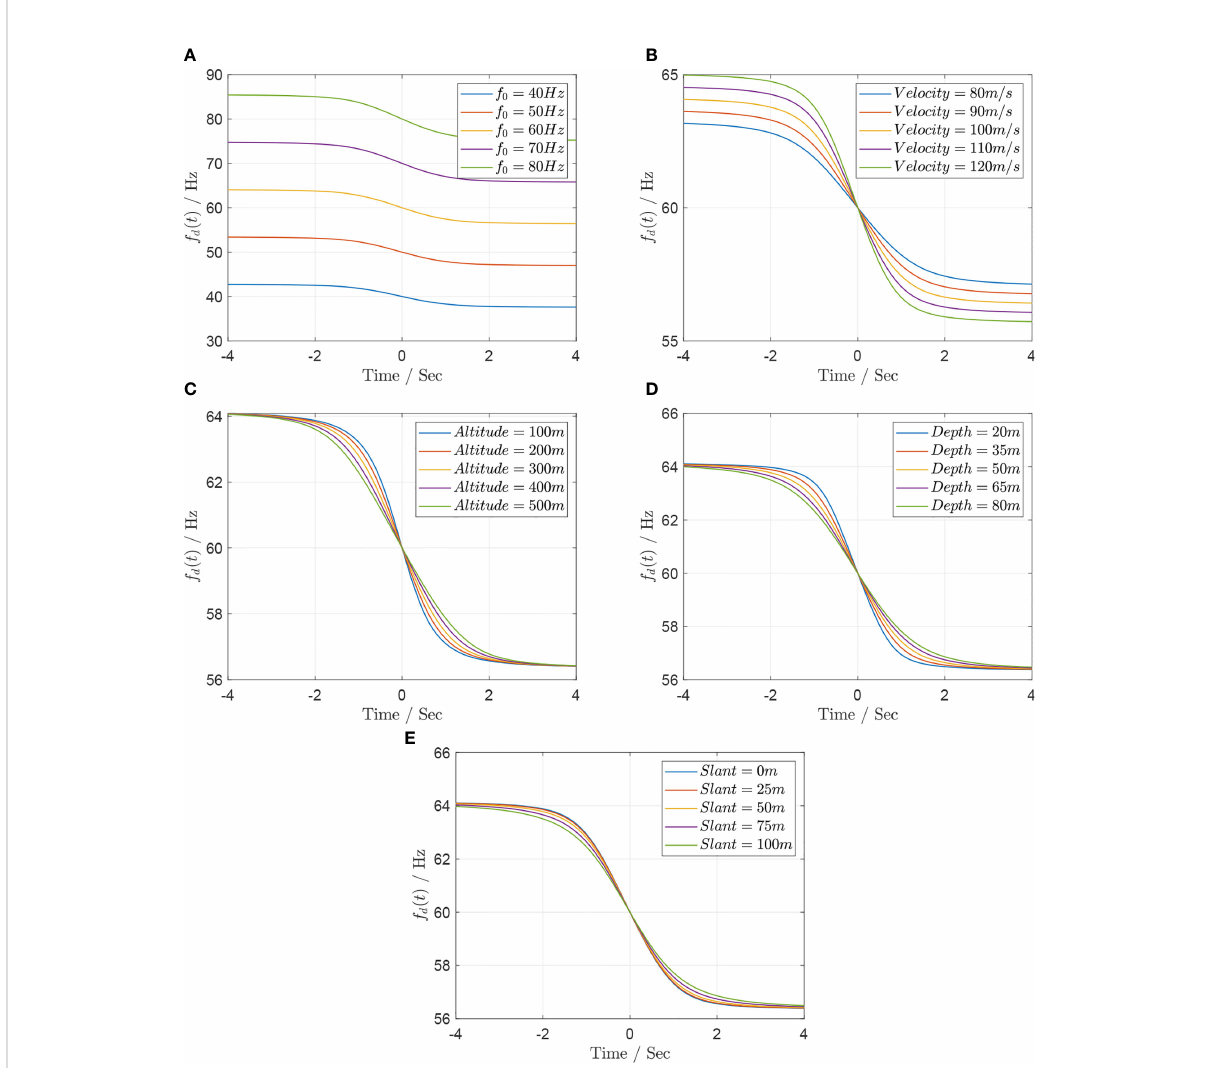
FIGURE 4 (A) Doppler shift curve f d ( t ) versus frequency f ∈ [30, 70] Hz every 10 Hz, assuming v = 100 m/s, h = 300 m, d = 50 m, and wmin = 50 m. (B) Doppler 0 shift curve f d ( t ) versus frequency v ∈ [80, 120] m/s every 10 m/s, assuming f 0 = 60 m/s, h = 300 m, d = 50 m, and wmin = 50 m. (C) Doppler shift curve f d ( t ) versus frequency h ∈ [100, 500] m every 100 m, assuming f 0 = 60 m/s, v = 100 m/s, d = 50 m, and wmin = 50 m. (D) Doppler shift curve f d ( t ) versus frequency d ∈ [20, 80] m every 15 m, assuming f 0 = 60 m/s, v = 100 m/s, h = 300 m, and wmin = 50 m. (E) Doppler shift curve f d ( t ) versus frequency wmin ∈ [0, 100] m every 25 m, assuming f 0 = 60 m/s, v = 100 m/s, h = 300 m, and d = 50